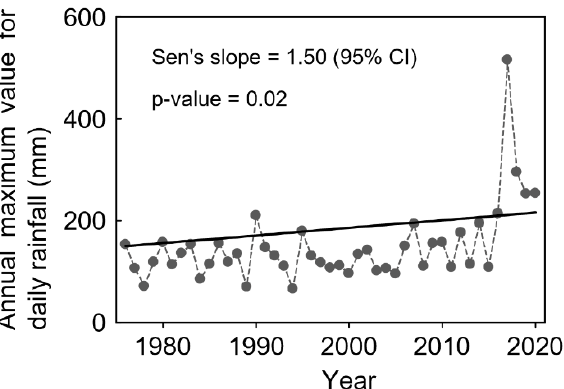
Figure 9. Annual maximum daily rainfall at the AMeDAS Asakura between 1976 and 2020. Gray circles indicate annual maximum value. Bold line indicates Sen’s slope (Hipel and McLeod 1996 [47]; Sen 1968 [48]) ( p < 0.05).